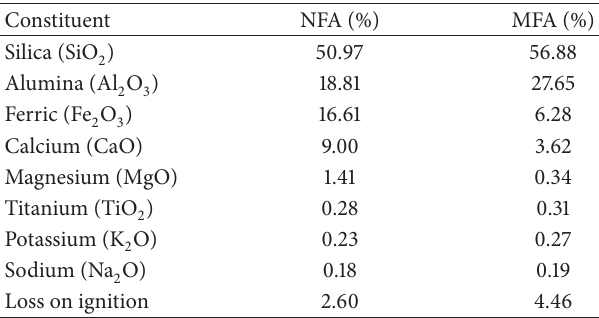
Table 1: Chemical composition of fly